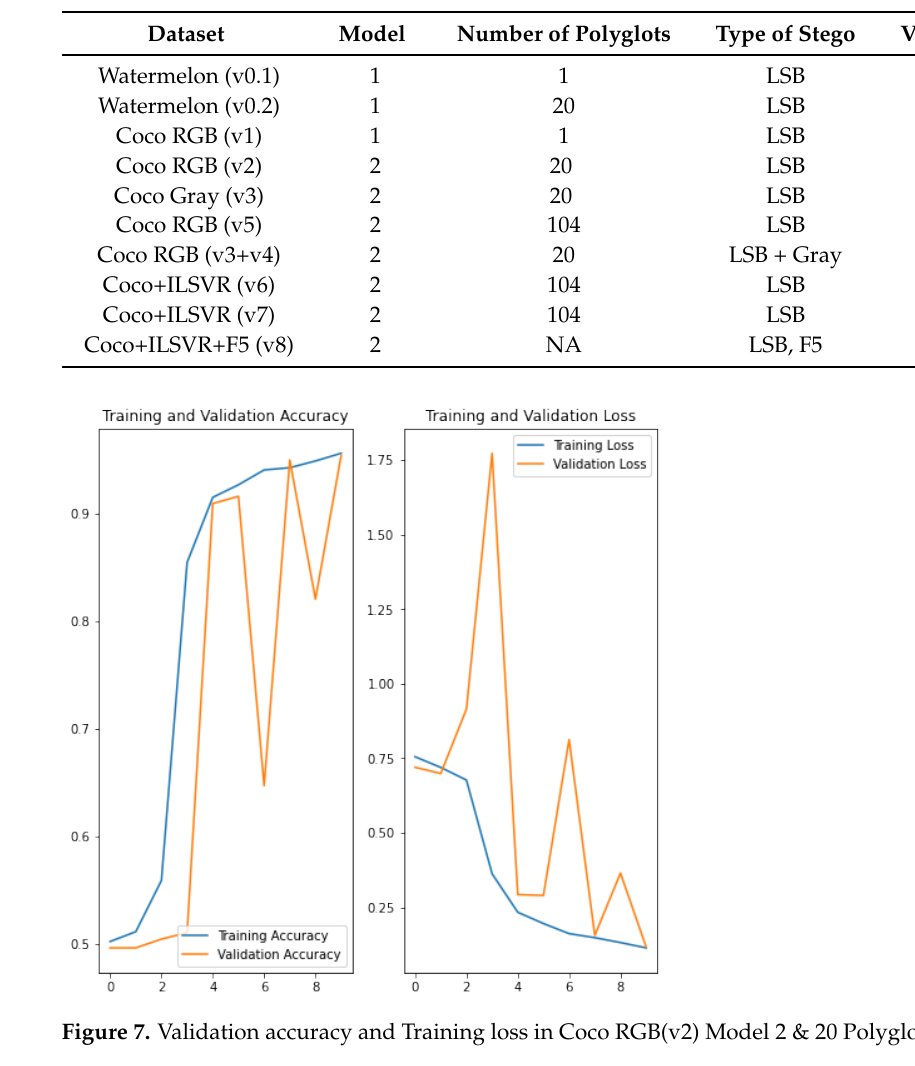
Table 1. Results of Experiments.